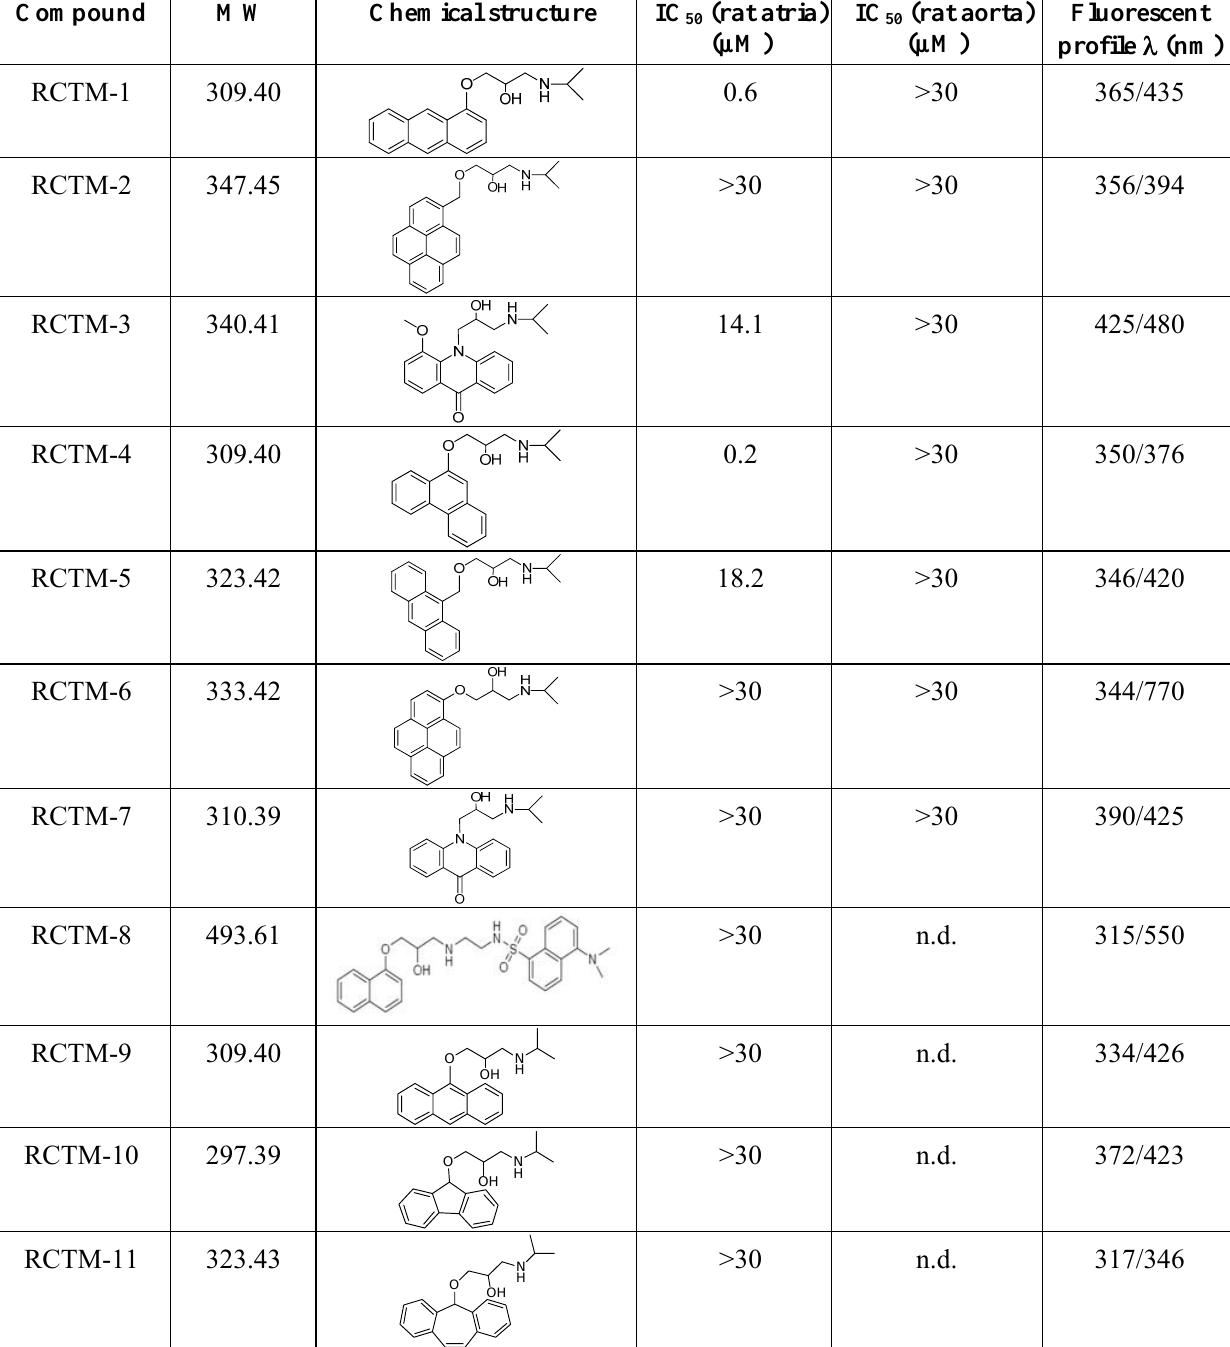
Table 1. Chemical structures, EC50 in rat atria and aorta, as well as the fluorimetric properties of the new